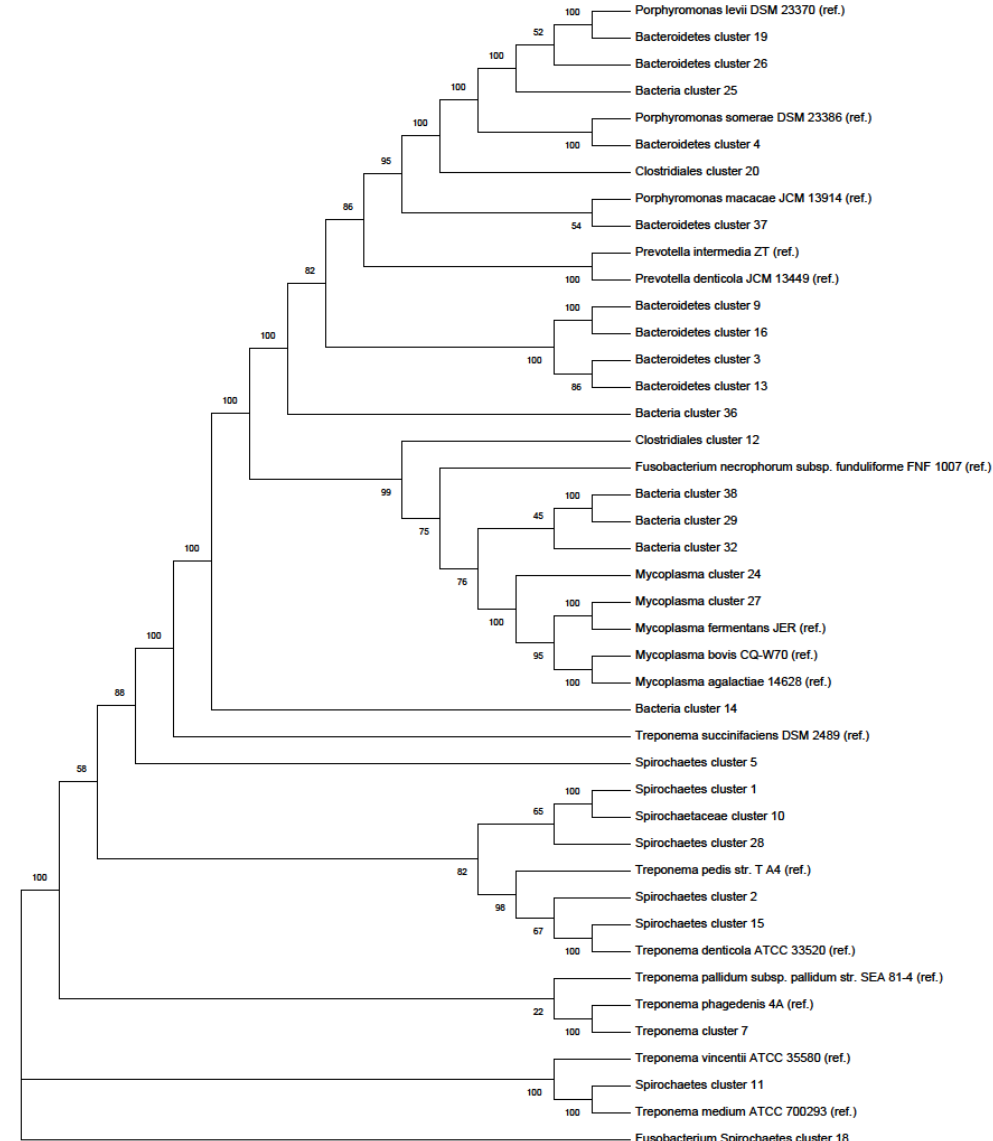
Figure 1. Phylogenetic tree of Spirochaetes , Bacteroidetes , Mycoplasma , and Bacteria from this study and reference organisms (which are labeled as “ref.”). In the construction of this dendrogram, we included the sequences of selected organisms identified in the current study and previous studies as well reference organisms, and PATRIC online tool (https://www.patricbrc.org/app/PhylogeneticTree (accessed on 22 February 2021)) was used.